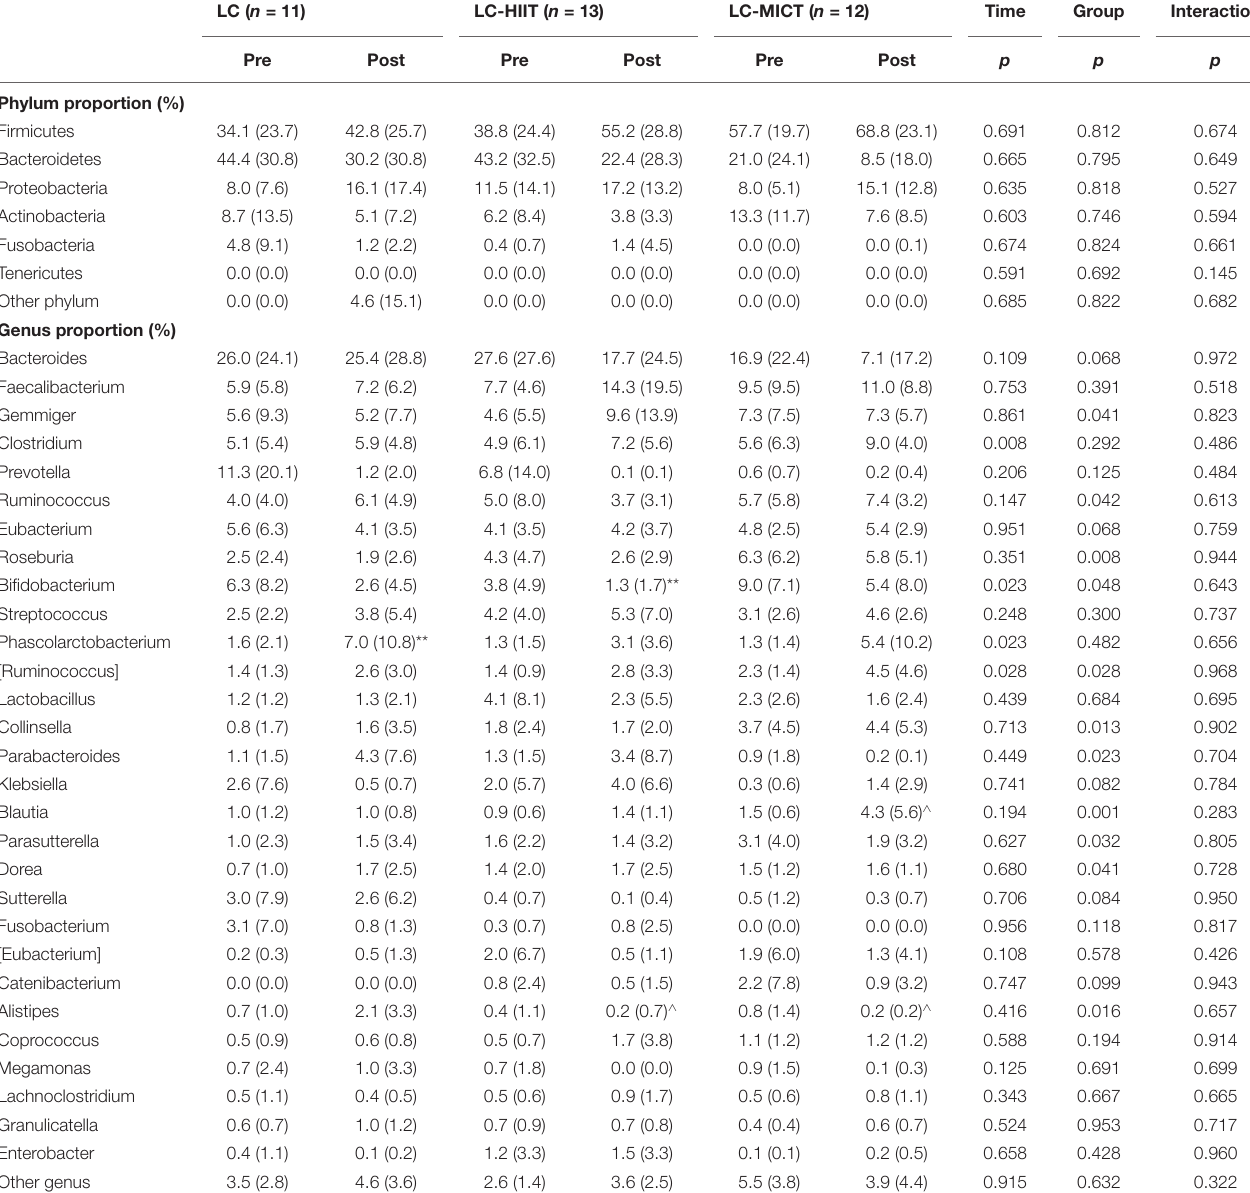
TABLE 2 | Phylum proportion (%) and genus proportion (%) before and after LC with/without training. LC ( n = 11) LC-HIIT ( n = 13) LC-MICT ( n = 12) Time Group